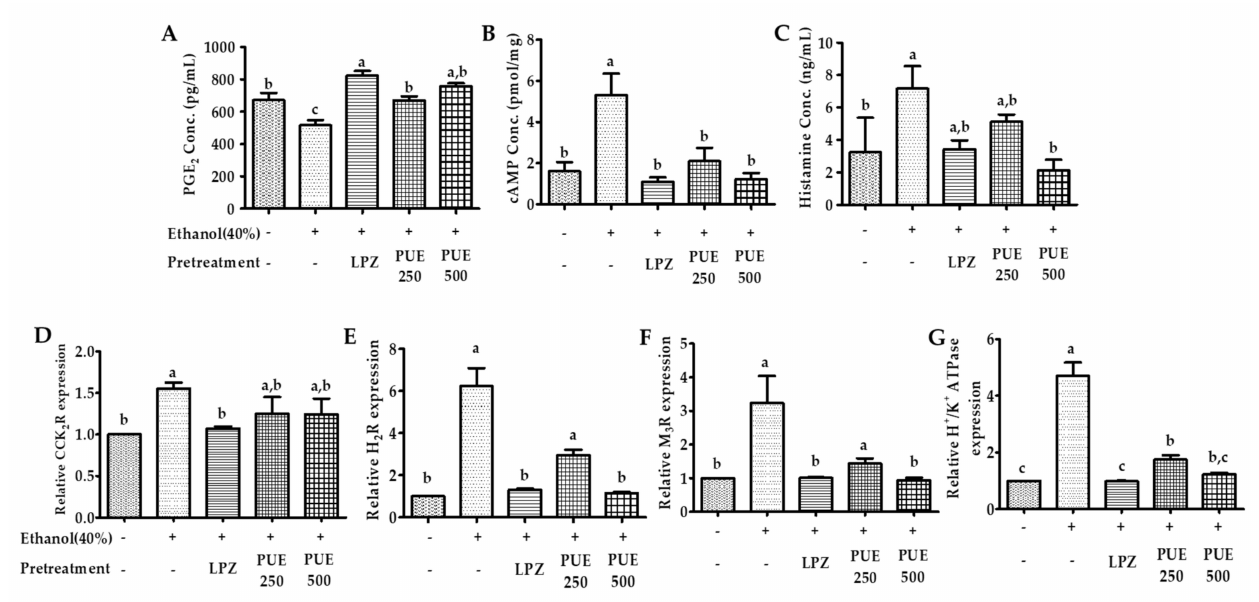
Figure 7. Effects of PUE on plasma biomarkers and relative gene expression. ( A ) Plasma prostaglandin E2 (PGE2) content (pg/mL); ( B ) gastric cAMP (nmol/mL); ( C ) plasma histamine concentration (ng/mL); ( D – G ) show the relative gene expression of the CCK receptor, H2-receptor, M3-receptor, and H+/K+ ATPase, respectively. In the graph, all values are expressed as the mean ± SEM, and values with different letters indicate significant differences ( p <